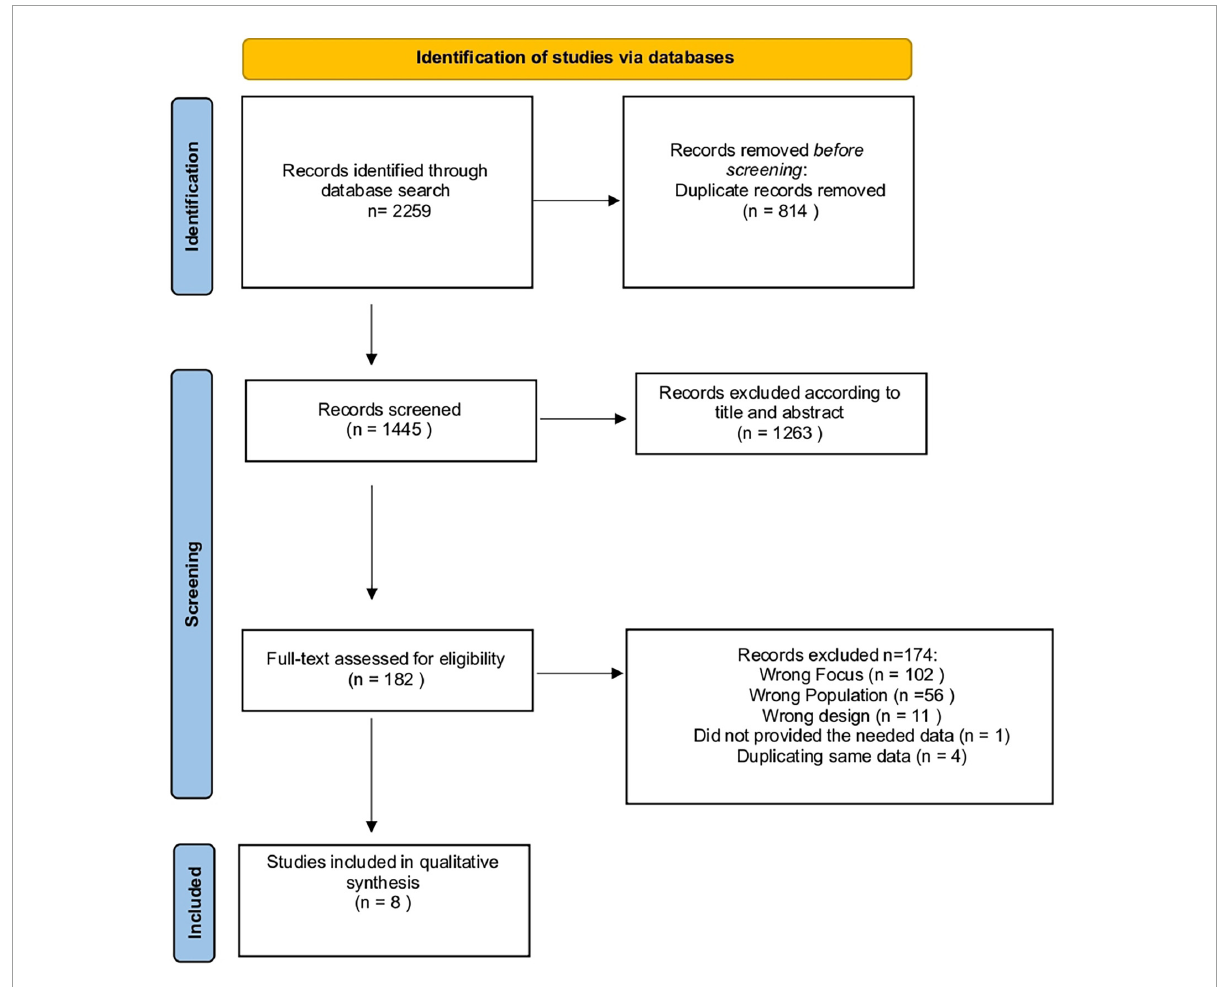
FIGURE1 Prisma flow